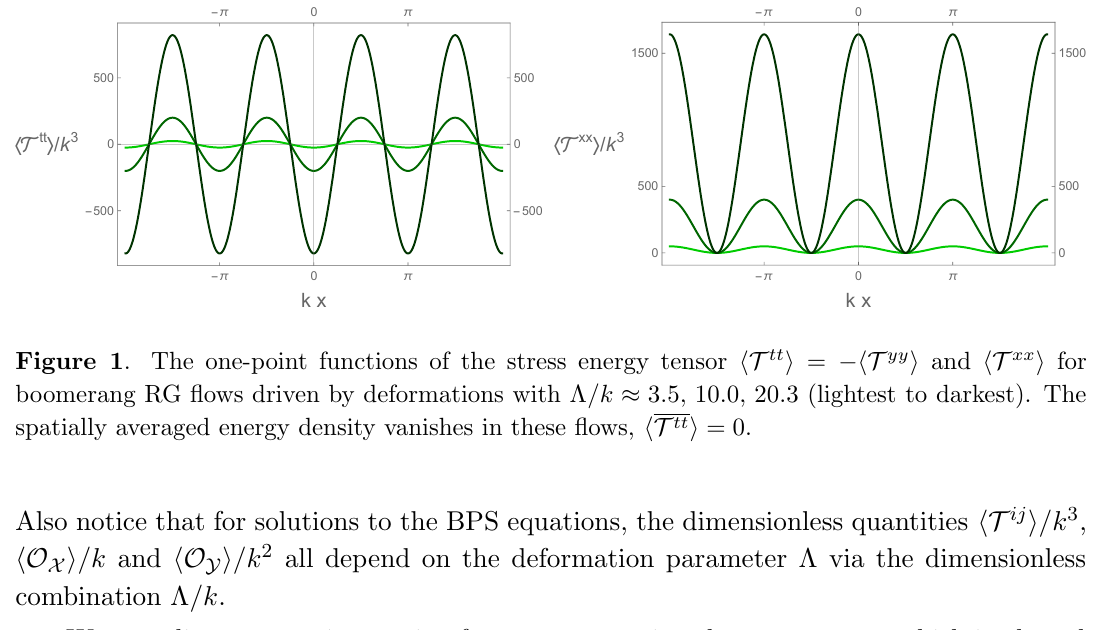
Also notice that for solutions to the BPS equations, the dimensionless quantities hT ij i =k 3 , hO i =k and hO i =k 2 all depend on the deformation parameter (cid:3) via the dimensionless X Y combination (cid:3) =k